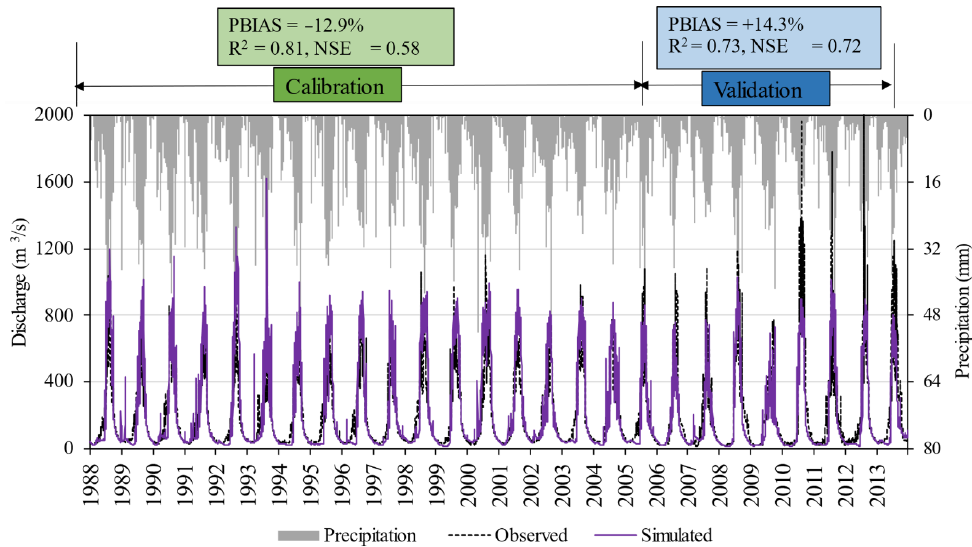
Figure 5. The calibration and validation results of the SWAT model. The calibration period is 1988–2006 and the validation period is 2007–2013.